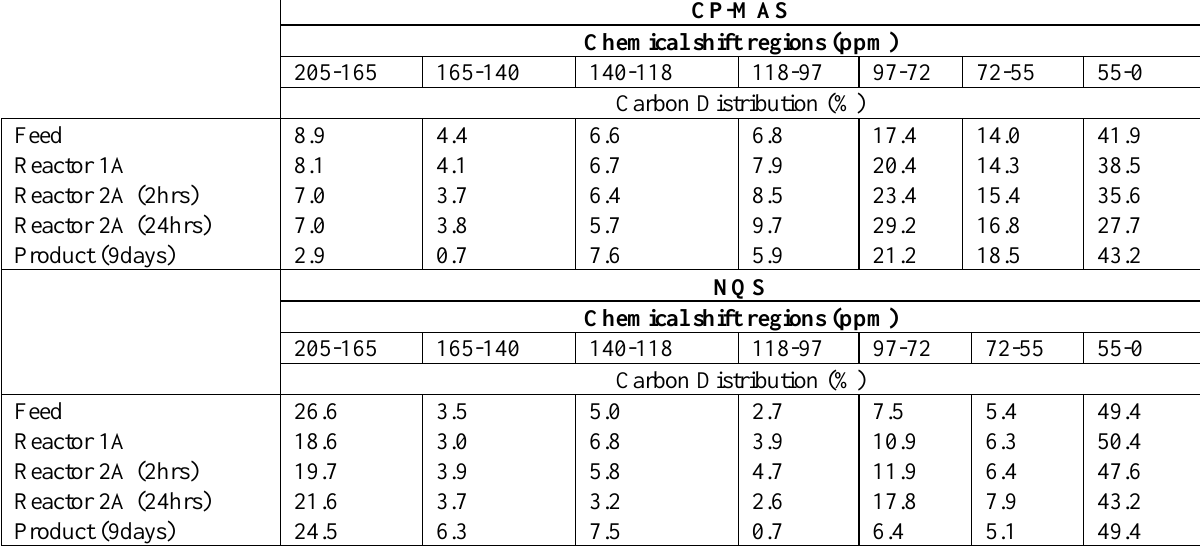
Table 4. Integration values for the major organic C-type domains in the CP-MAS (CP) and NQS 13 C- NMR spectra of sludge samples obtained from different stage of ATAD biosolids processing (values shown as % of the integration value of total C). Chemical shifts are shown in part per million units